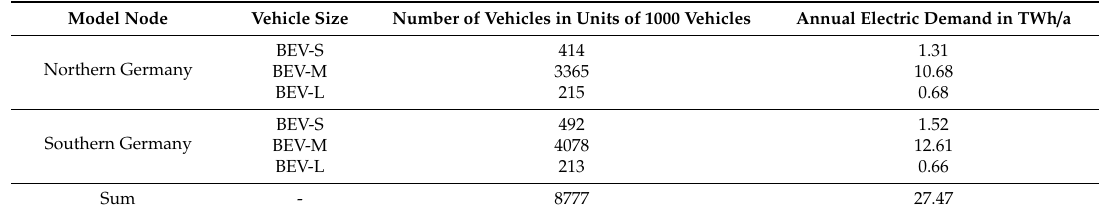
Table 5. EV fleet spatially dependent parameters as aggregated results from VECTOR21